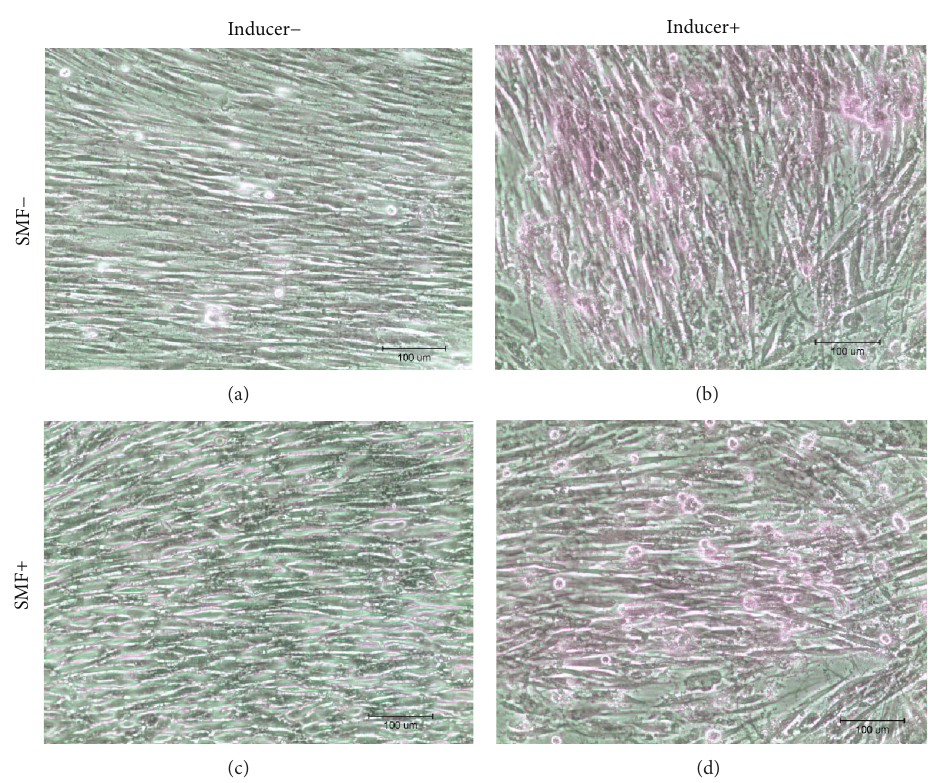
Figure 5: Safranin O staining results showed the glycosaminoglycan extracellular matrix around the cells in pink to red after chondrogenesis induction. No significant differences could be observed between SMF-exposed and sham-exposed DPCs after adipogenesis induction.